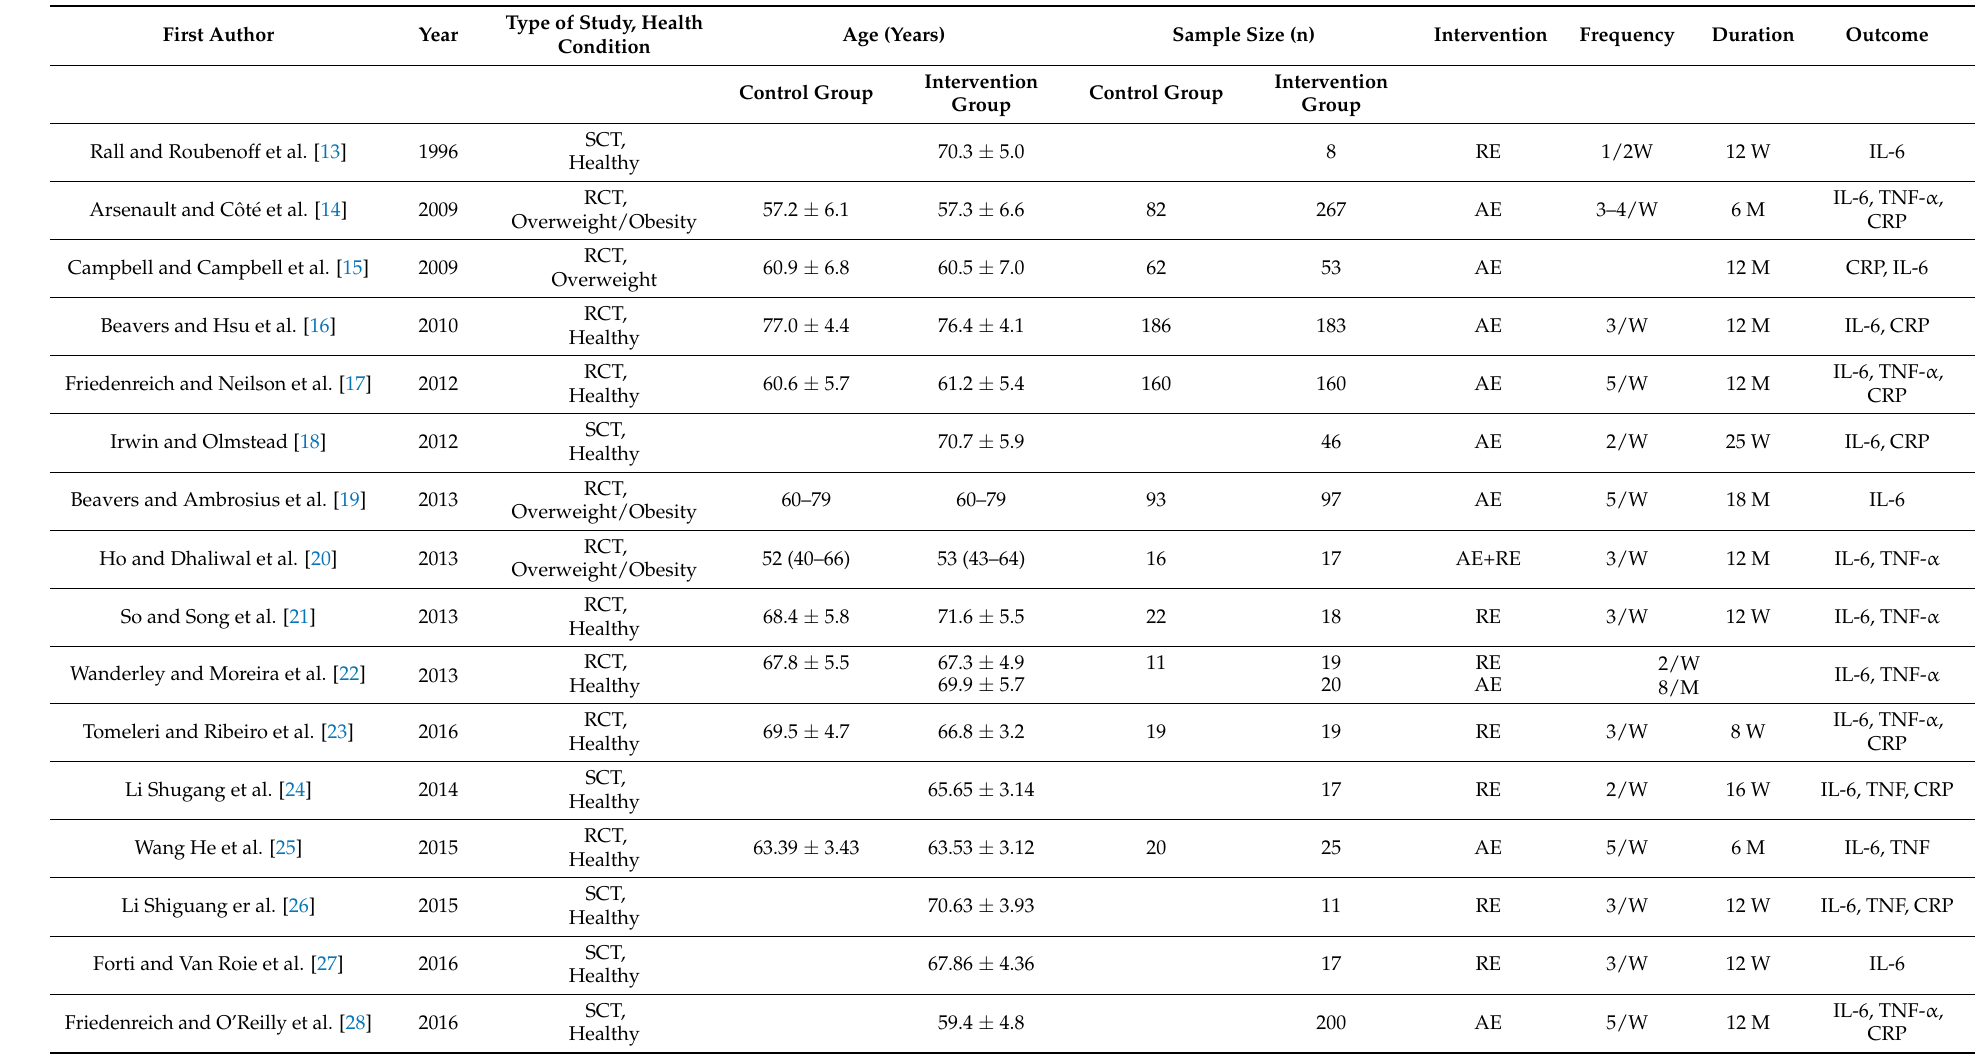
Table 1. General features of selected research